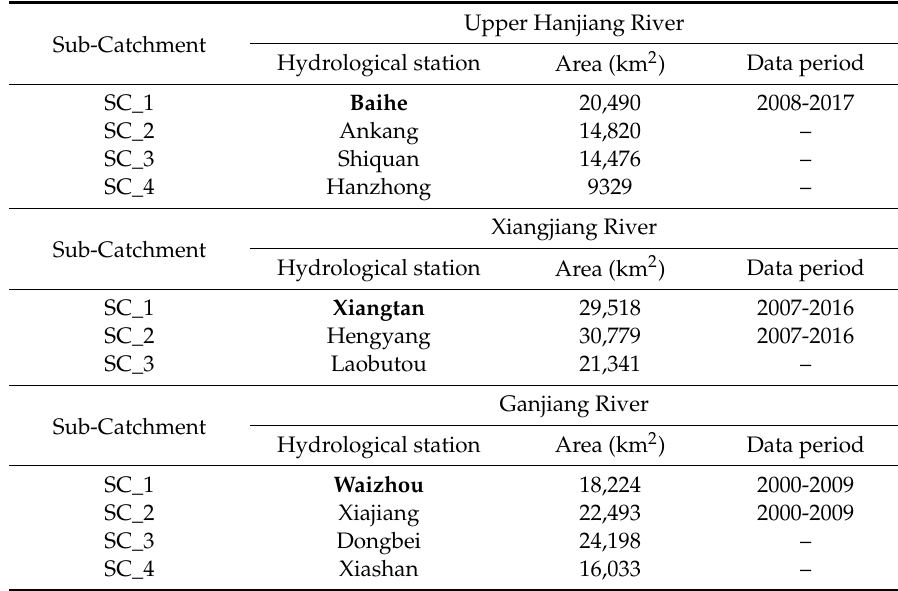
Table 1. Information on sub-catchments, their area, and data used in the semi-distributed setup. The bold name indicates the outlet of